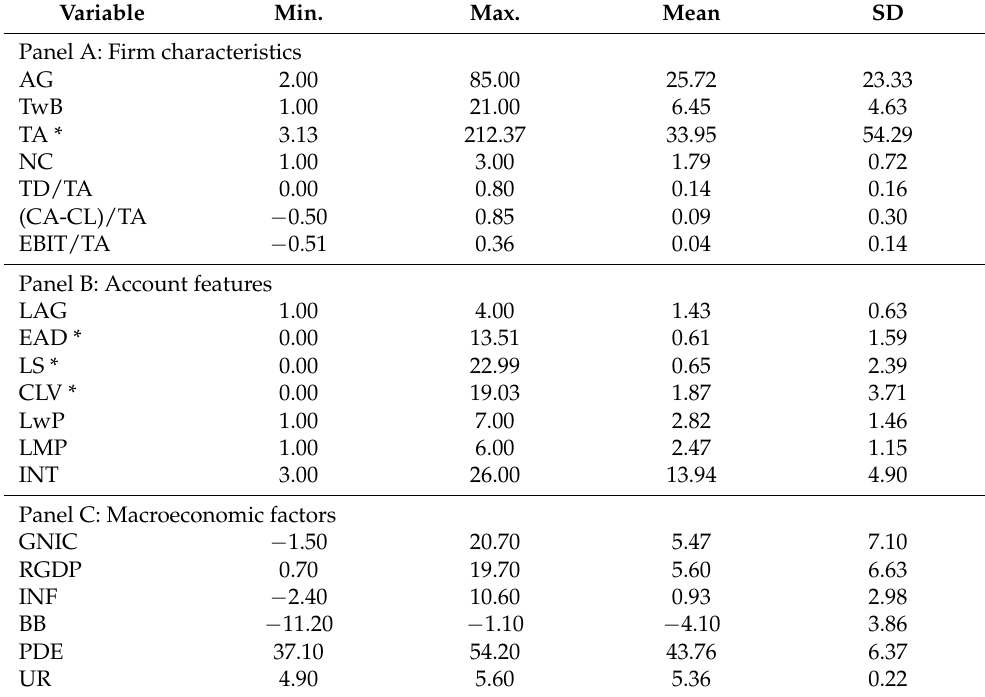
Table A1. Firm characteristics, account features and macroeconomic factors with descriptive